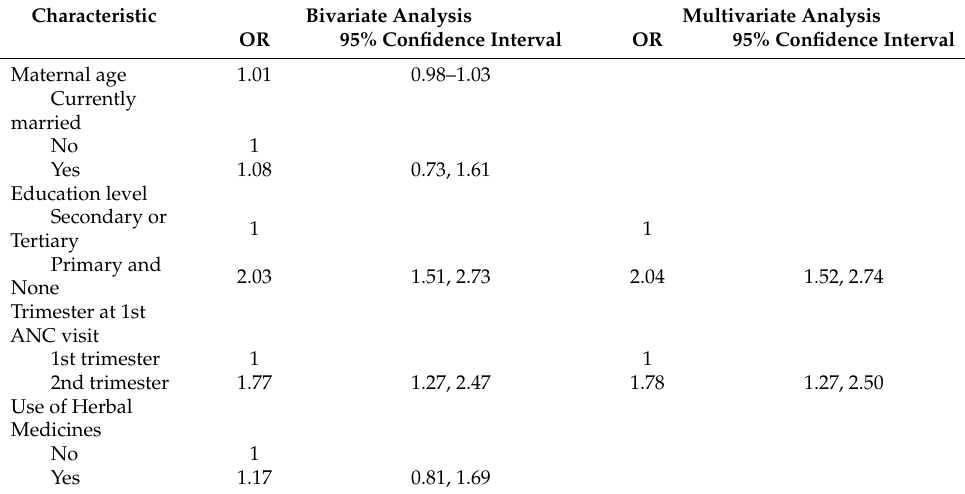
Table 3. Factors associated with poorer compliance to anemia-preventive strategies among study participants.